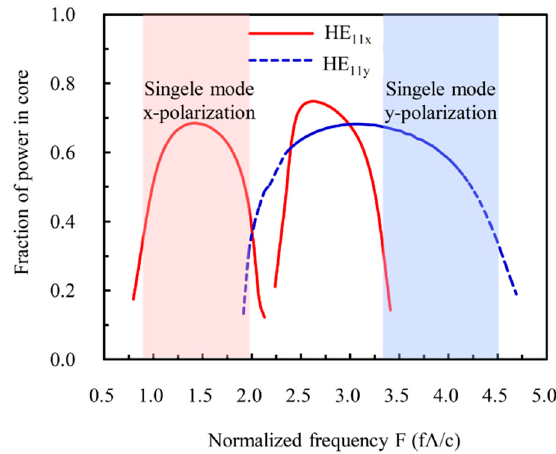
Figure 4. Fraction of core confined energy as a function of normalized frequency and single-mode single-polarization operation regions of the designed THz LC-MOF.